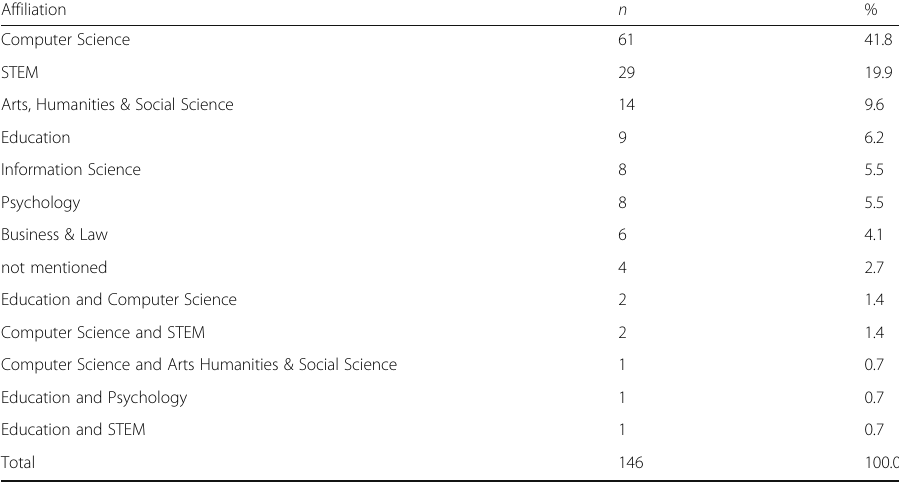
Table 5 Affiliation of the first author ( n = 146 articles)